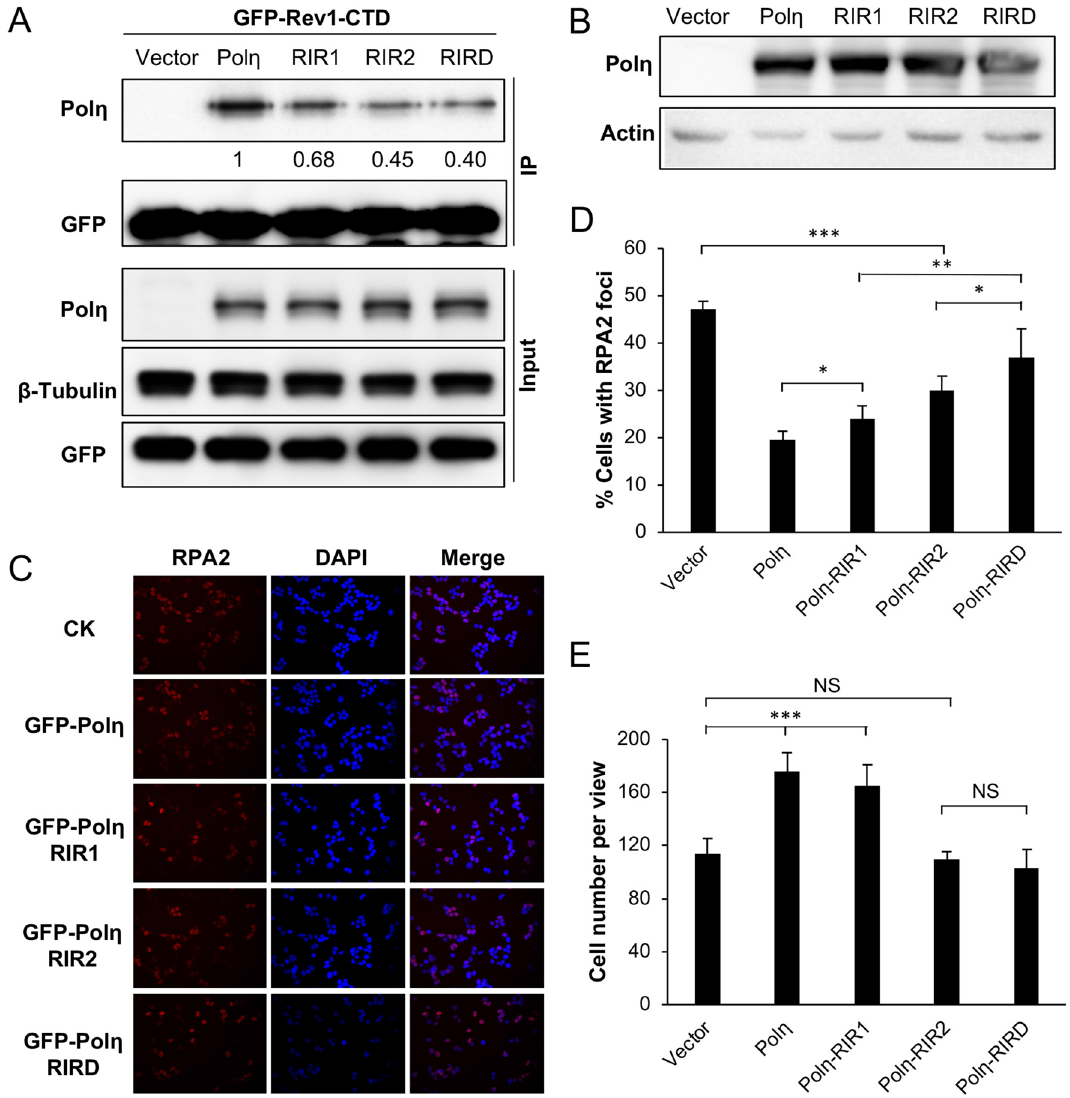
Figure 6. Effects of Polη and its mutant derivatives on UV damage response in POLH-1 cells. ( A ) Co-IP assays to assess the interaction between Rev1 and mutated Polη in POLH-1 cells. ( B ) Western blot analysis of ectopic expression of POLH and its mutations in POLH-1 cells. ( C , D ) Effects of Polη and its mutations on preventing UV-induced RPA2 nuclear focus formation. POLH-1 cells were transfected with the indicated plasmids and then incubated for 2 days before 4 J/m 2 UV irradiation, followed by continued culture for 6 h and staining with DAPI or an antibody against RPA2. ( C ) Representative images of the RPA nuclear focus assay. ( D ) Quantitative analysis. ( E ) Effects of Polη and its mutations on POLH-1 cell growth in response to UV irradiation. Cells were transfected with plasmids expressing Polη or its point mutations before 2 J/m 2 UV irradiation, then these cells were cultured for 48 h, followed by counting viable cells. ( D , E ) Results are means of three independent experiments ± SEM. *, P < 0.05; ** P < 0.01; ***, P < 0.001, NS, not significant by two-sided Student’s t GFP and western blot analysis against Polη. Figure 6A shows that, compared to wild-type Polη, the Polη-RIR2 mutation had a stronger effect on binding to GFP-Rev1-CTD than the Polη-RIR1 mutation, and the Polη-RIRD double mutation further reduced its affinity for GFP-Rev1-CTD. Hence, RIR2 appears to play a major role in the Polη-Rev1 interaction. The remaining coimmunoprecipitated Polη may come from indirect interactions, as both Rev1 and Polη interact with PCNA and Ub 3,16,29,31 , or from other putative RIR motifs found in Polη 22 . We transfected plasmids producing GFP-Polη and its RIR mutant forms in POLH-1 cells and monitored their response to UV irradiation. Mutant forms of GFP-Polη did not affect their expression and protein stability in POLH-1 cells under our experimental conditions (Fig. 6B). Expression of POLH in POLH-1 reduced UV- induced RPA2-positive cells to a great extent, and expression of POLH-RIR1 and POLH-RIR2 mutations partially restored the Polη function in POLH-1 cells, while expression of the POLH-RIRD double mutant form of Polη further reduced its rescue ability (Fig. 6C,D). Hence, Polη-RIR1 and Polη-RIR2 mutations appear to be additive in affecting Rev1 interaction, which plays a critical role in TLS. In a cell survival assay, expression of POLH restored